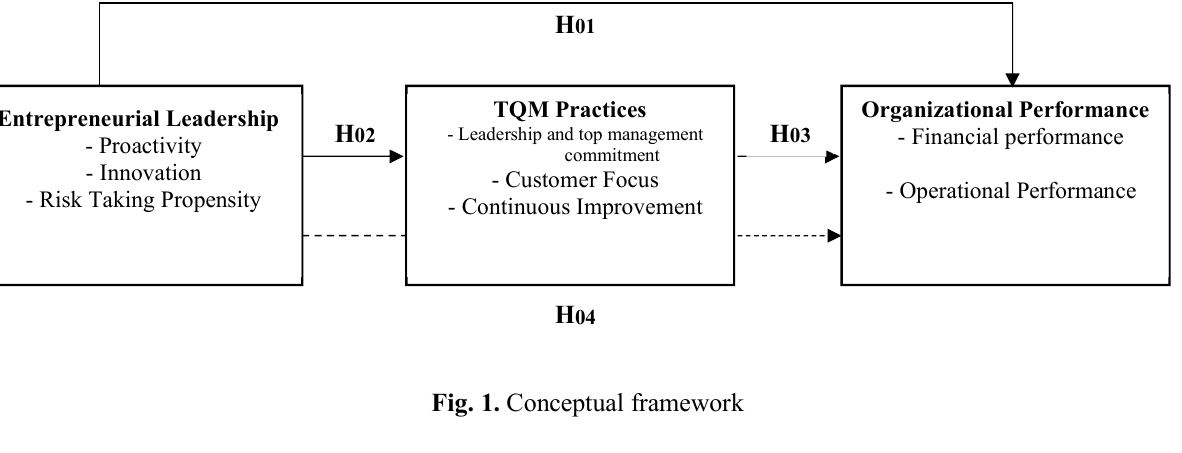
Fig. 1. Conceptual